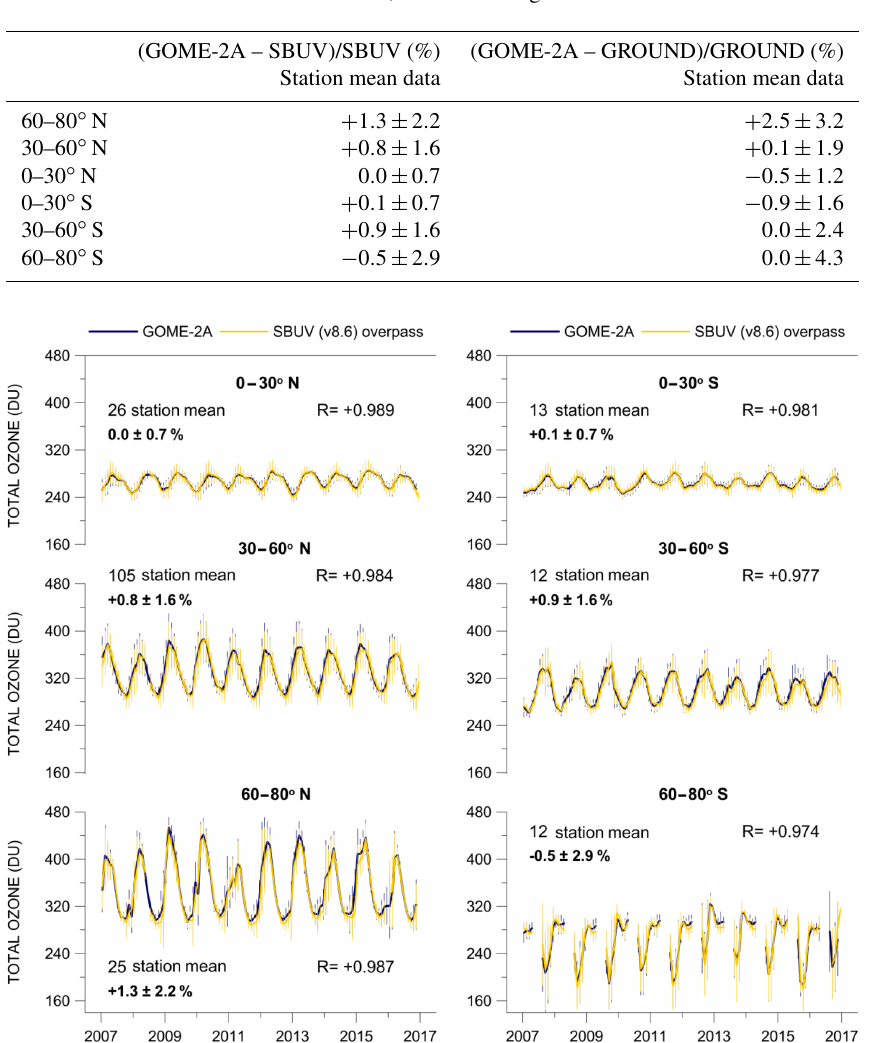
Figure 1. Monthly mean total ozone from GOME-2A compared with monthly mean total ozone from SBUV (v8.6) satellite overpass data for the period 2007–2016 over the Northern and the Southern Hemisphere, based on station mean data. R is the correlation coefficient between the two lines. Error bars show the standard deviation of each monthly mean. Mean differences ± σ are given as (GOME-2A – SBUV)/SBUV